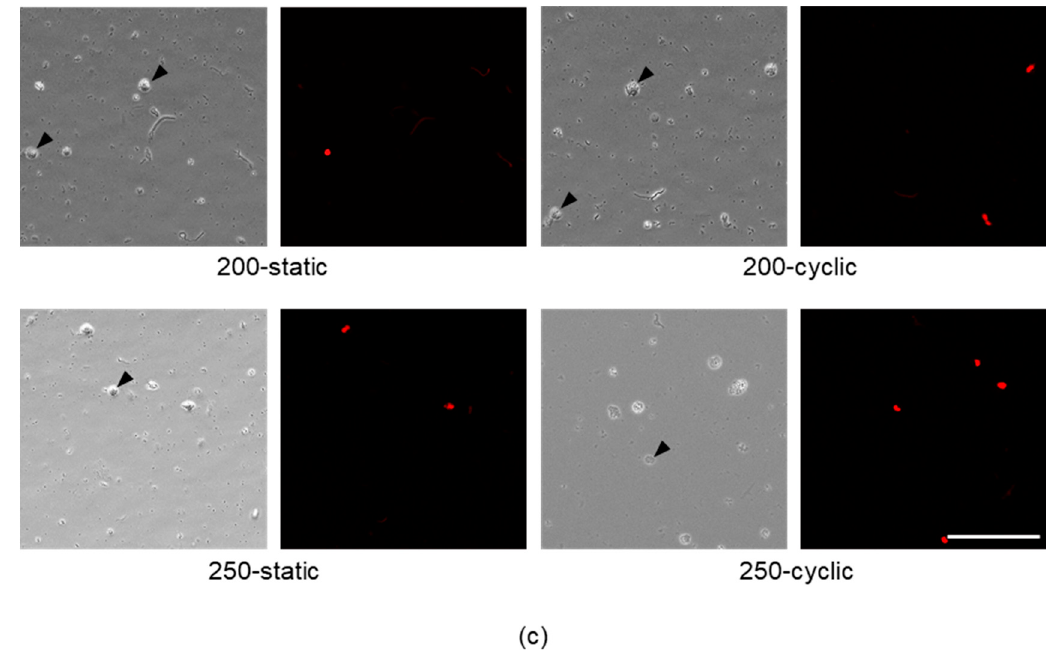
Figure 5. Evaluation of cell viability after HHP application. ( a ) Calcein-AM / PI staining precipitated by centrifugation. Scale bar: 500 µ m. ( b ) Quantity of DNA normalized by control group in precipitated cells at 0 h. Data are presented as mean ± S.D., n = 6. * indicates significant differences between static and cyclic groups at the same pressure (*: p < 0.05). ( c ) Phase-contrast images (left) and images of calcein-AM / PI staining (right) at the same area in 200-static, 200-cyclic, 250-static, and 250-cyclic groups in the supernatant. Scale bar: 100 µ m.